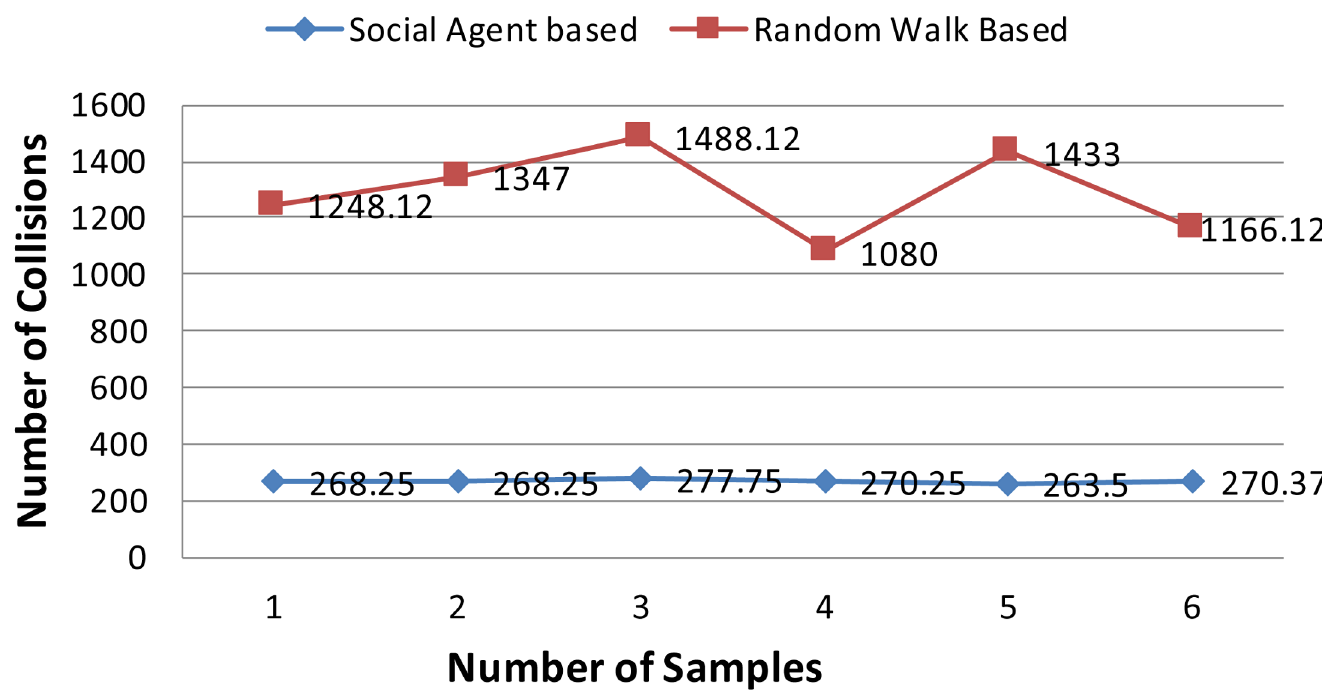
Fig 4. Graphical representation of test case 1.